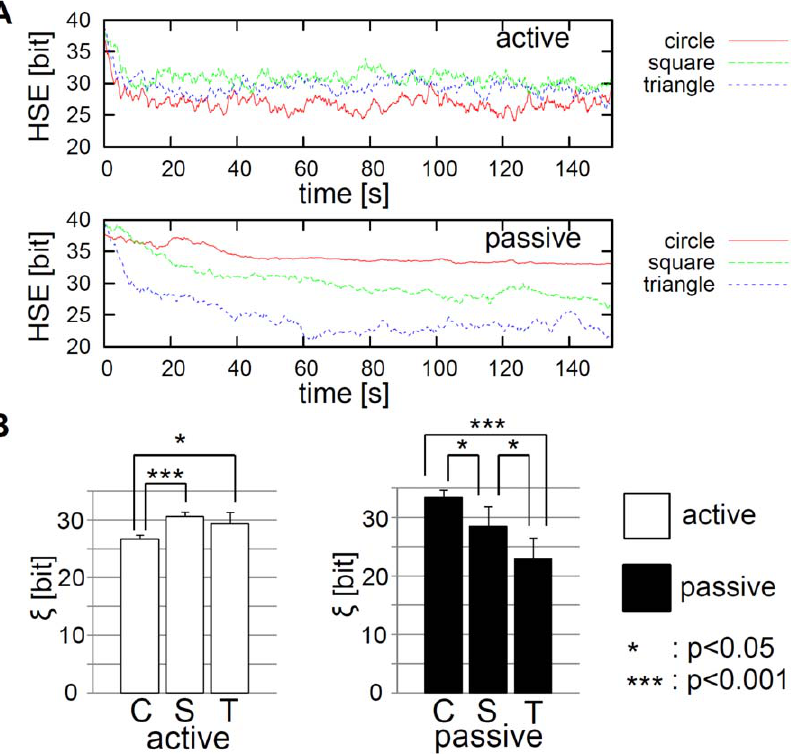
Figure 10. Comparisons of the averaged HSE and the averaged j . A. Comparisons of the averaged HSE between the circular, square, and triangular cases for the active elements (the upper figure) and the passive elements (the lower figure). They are the same plot lines shown in the lower line of Fig. 8 A. , Fig. 8 B. , and Fig. 8 C. , but rearranged and overlaid into two plot lines; namely, the plot lines for the active and the passive elements. B. Comparisons of the averaged j between the circular, square, and triangular cases for the active elements and the passive elements. They are from the same plot shown in Fig. 9, but rearranged into bar graphs, one showing the active elements, one showing the passive elements. Asterisks indicate significant differences, (cid:2) : p v 0 : 05 , (cid:2) (cid:2) (cid:2) : p v 0 : 001 .